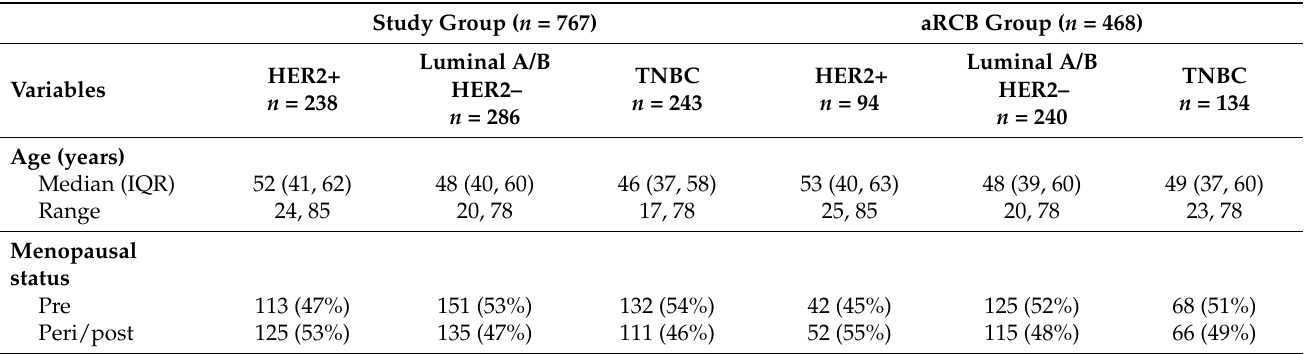
Table 1. Patient and tumor pretreatment characteristics and NAT regimens according to the subtypes. Study Group ( n =